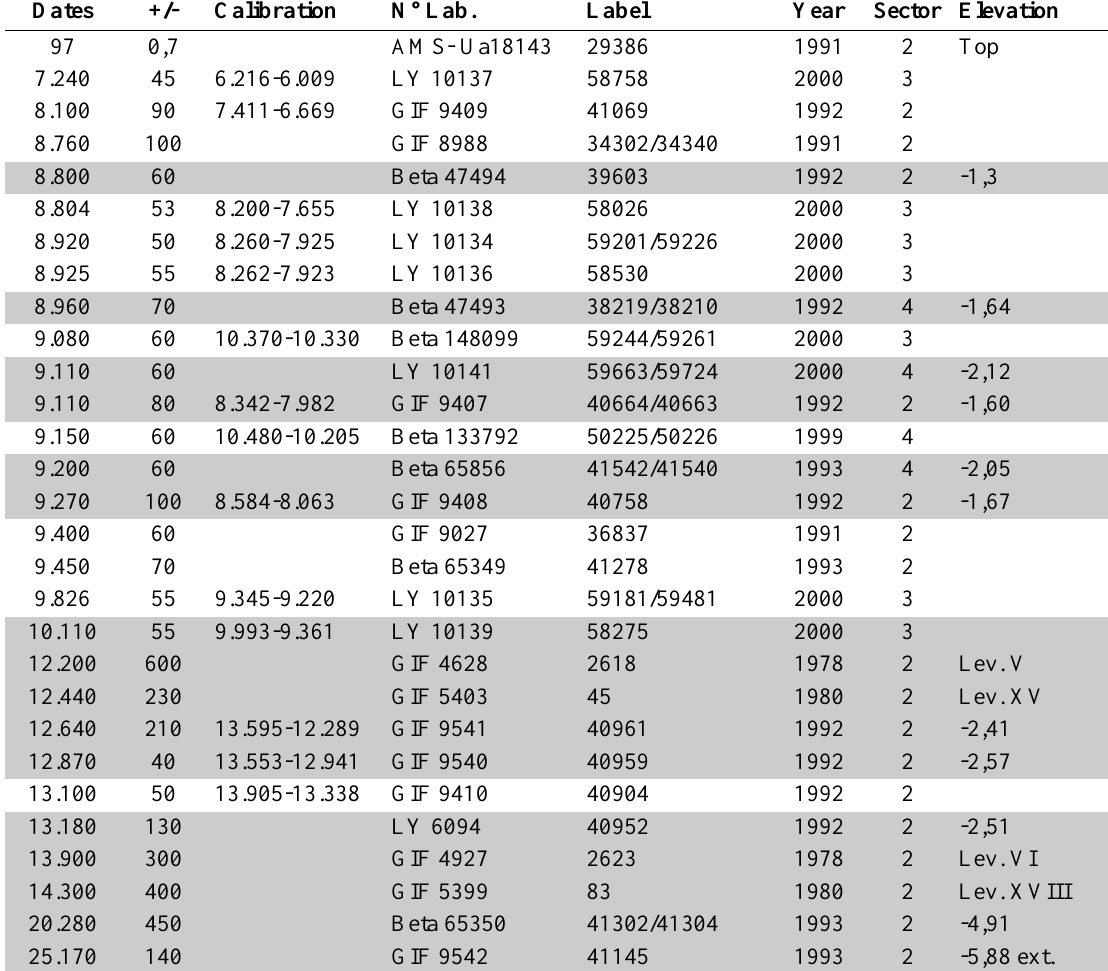
Table 2. 14C dates from SDM, shaded considered dates with a precise position. Calibration with